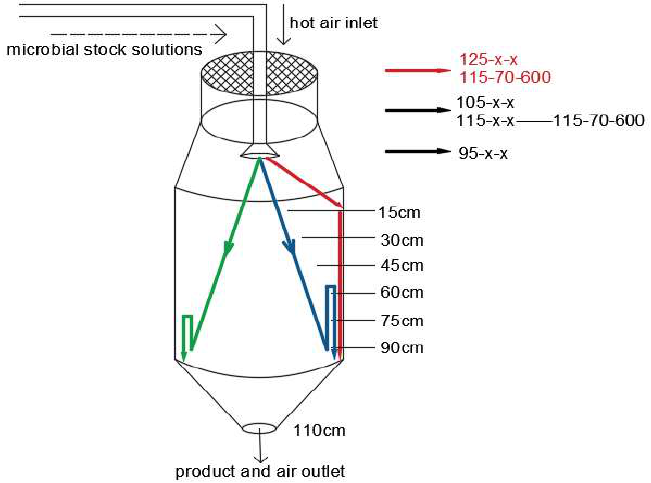
Figure 11. Schematic diagram of yeast particle trajectory under three groups of parameters.